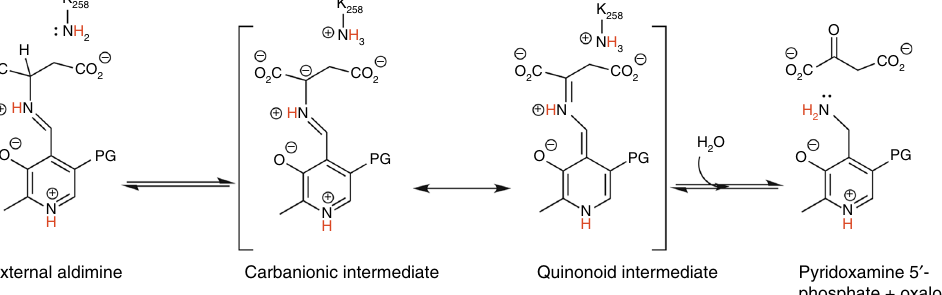
Fig. 4 Proposed mechanism for the fi rst half-reaction of AAT. The mechanism starts from the external aldimine obtained by substrate attack on the internal aldimine, as shown in Fig. 2b